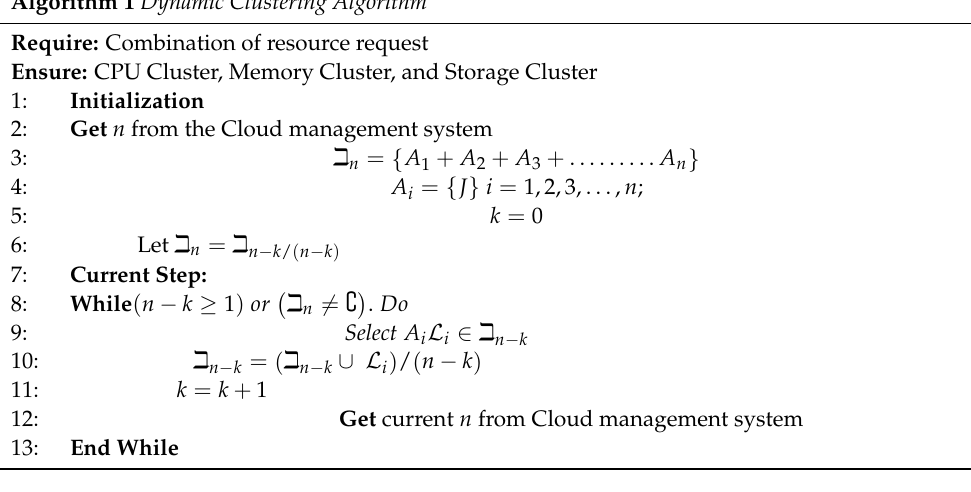
Algorithm 1 Dynamic Clustering Algorithm